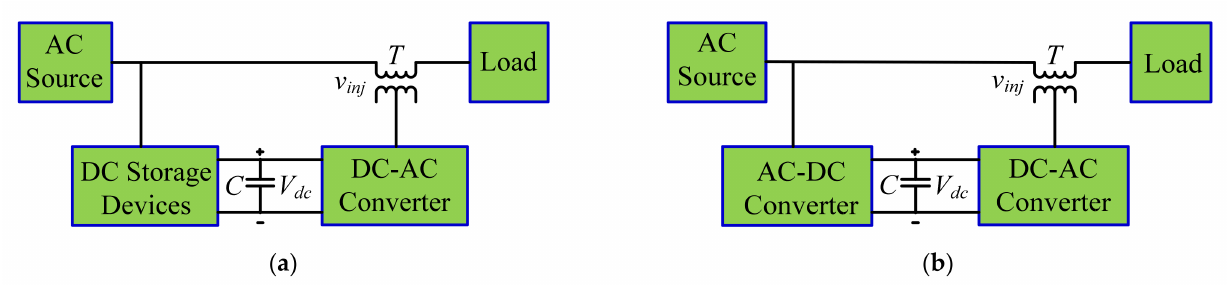
Figure 1. Conventional voltage compensation techniques employed ( a ) with and ( b ) without energy storage